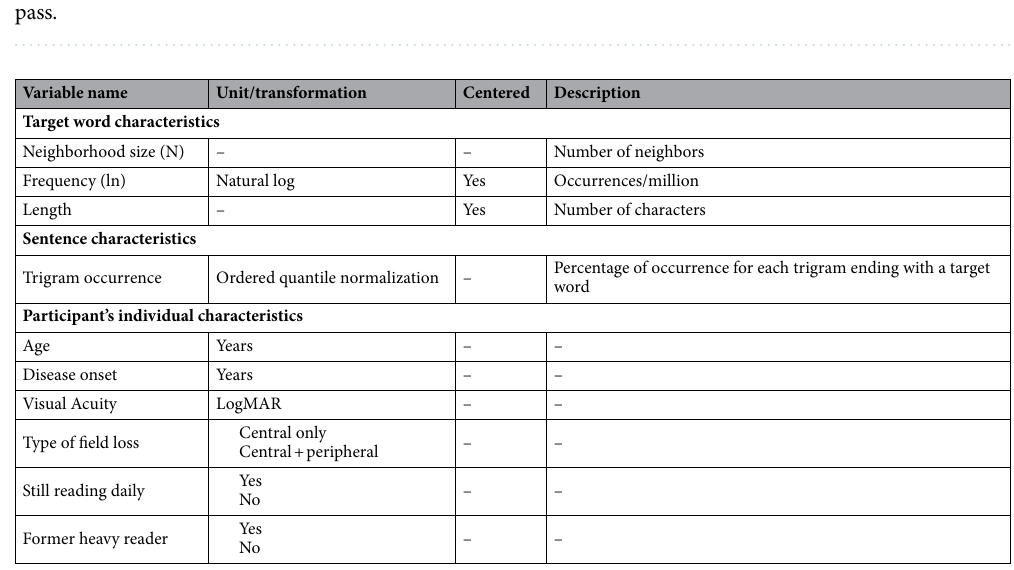
Figure 3. Self-paced Reading paradigm. Words are revealed one at a time by the participant, using keyboard presses. A press on the right arrow key will unmask the upcoming word (while masking the currently visible word) and a press on the left arrow key will unmask the previous word (while masking the currently visible word). For words unmasked only once (e.g. word 1), the total reading time equals the 1st-pass reading time. For words unmasked more than once (e.g. word 2), the total reading time is the sum of each individual reading time pass.